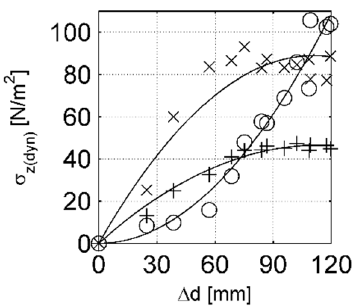
Figure 9. Dynamic lift for each peak, plotted with trend lines over change in flow